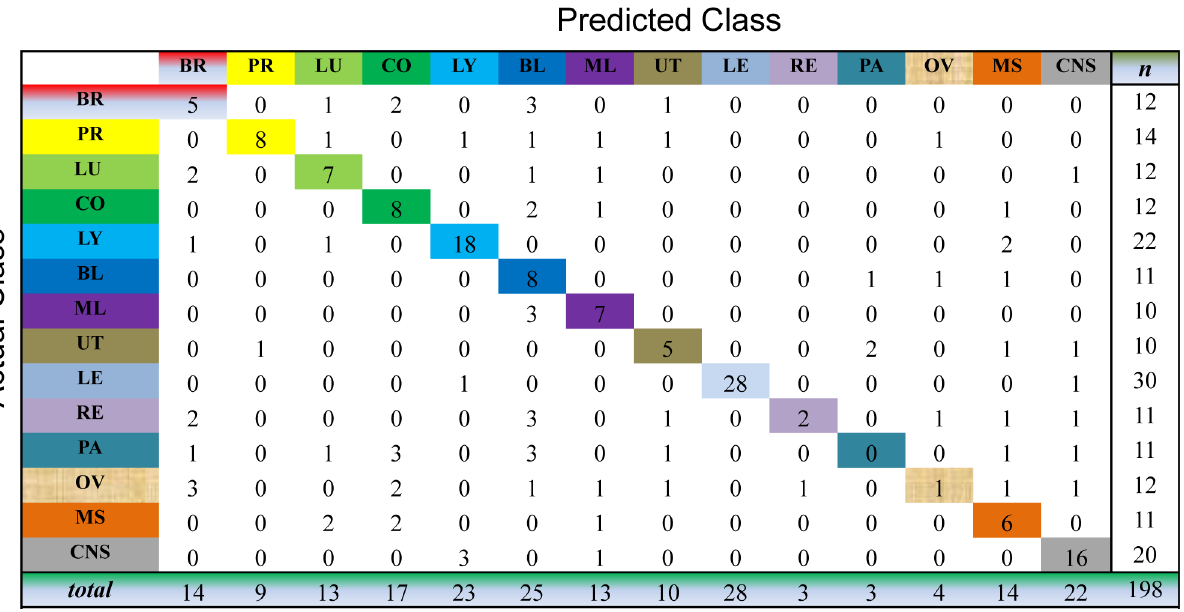
Fig 6. Confusion matrix of prediction results using LDS, which achieves a total accuracy of 60.1%. Matrix delineates distribution of actual compared with predicted class membership for multiclass cancer prediction on the GCM